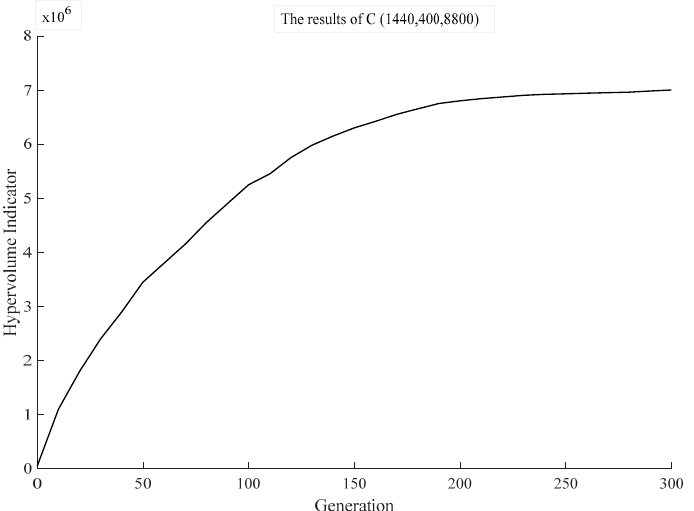
Figure 11. The hypervolume convergence curve.